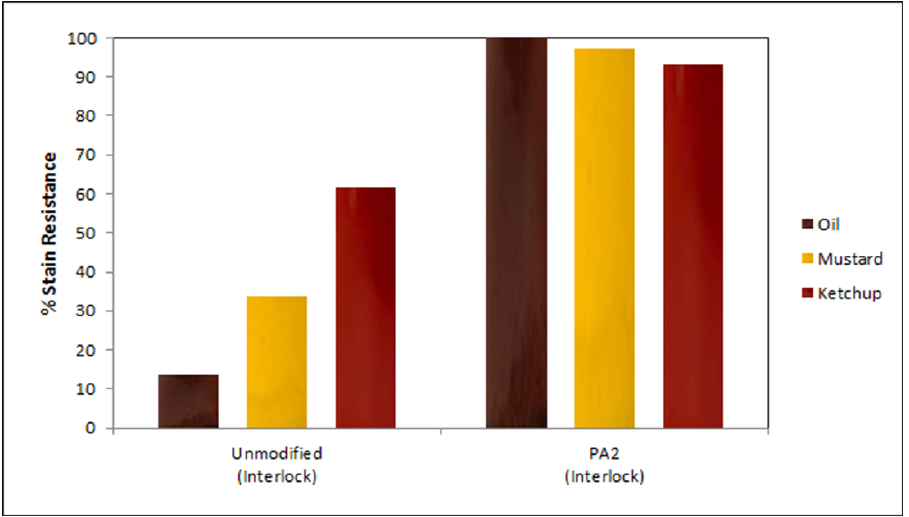
Figure 9. Stain resistance for untreated and treated fabric with PA2 with different staining agents.